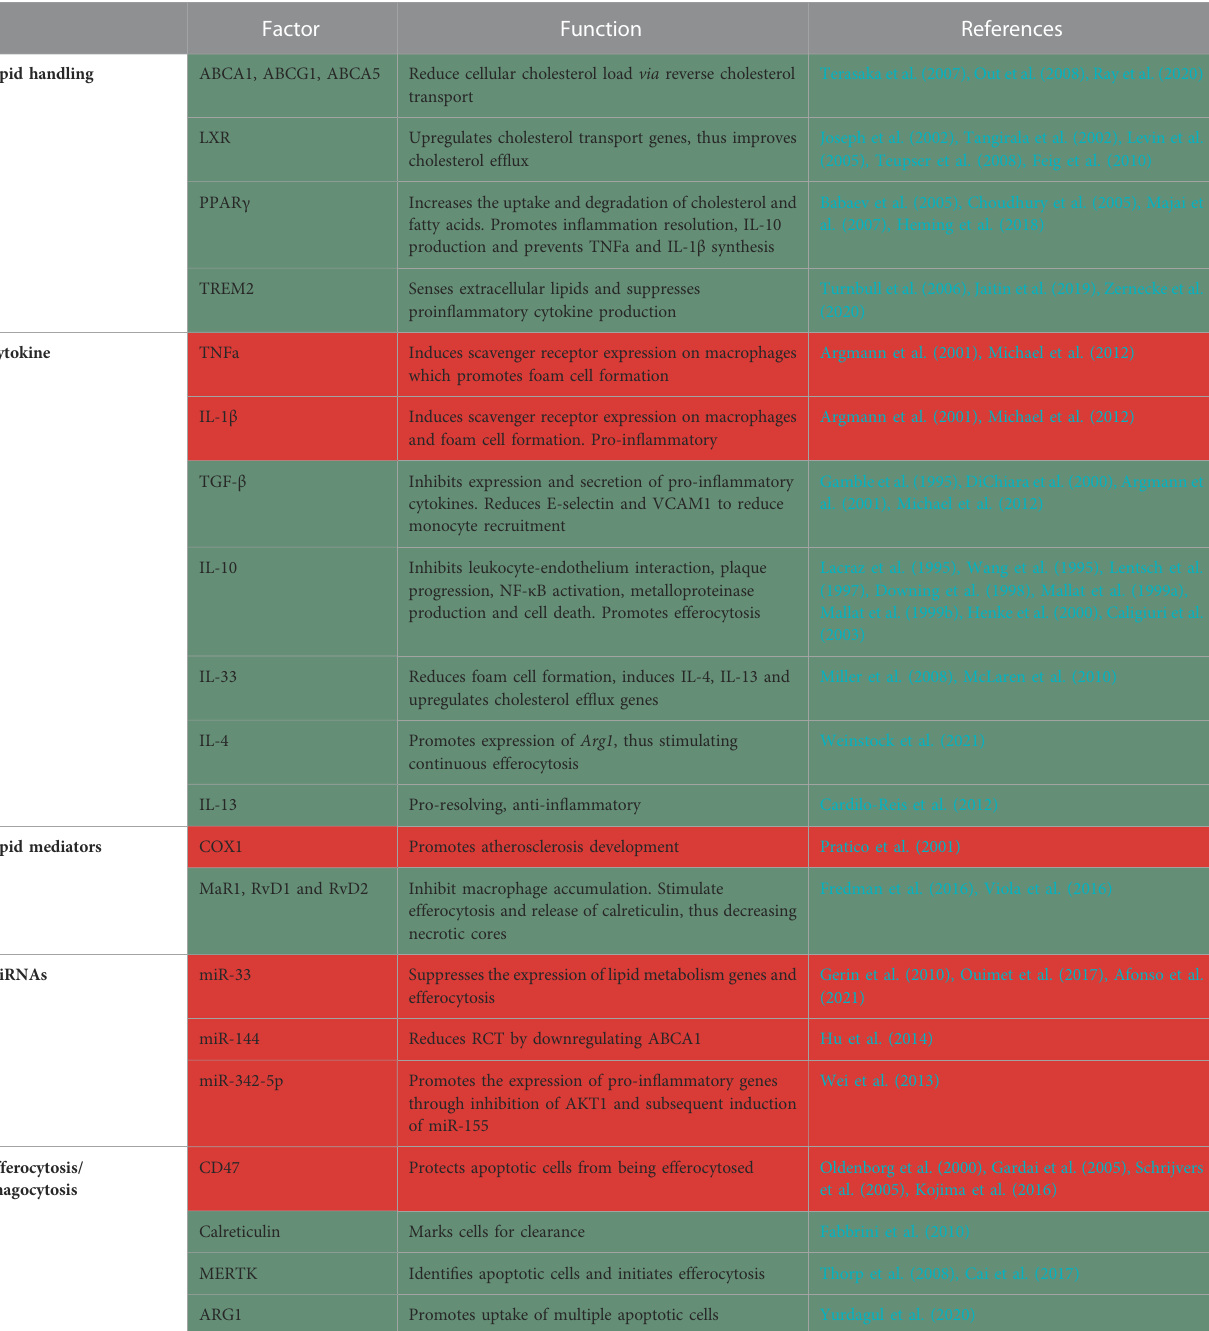
TABLE 2 Summary of factors in macrophages that protect from (green) or promote (red)